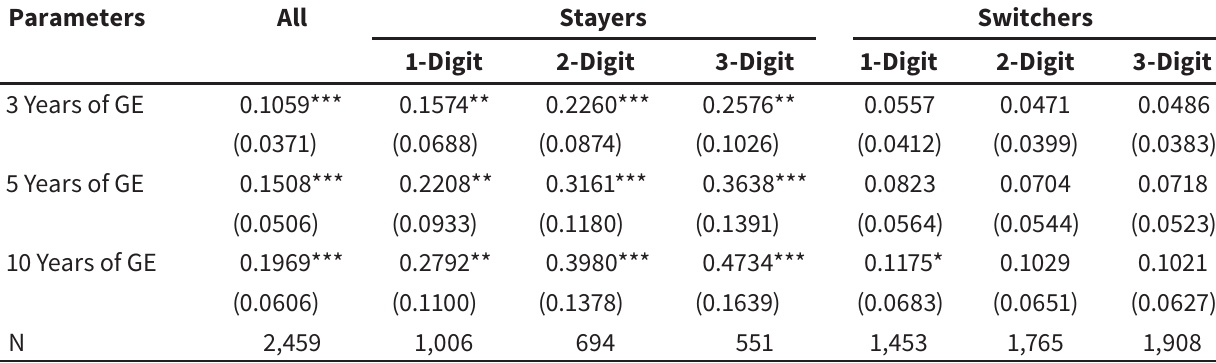
OLS estimates of cumulative returns to source country general experience (quartic) Parameters